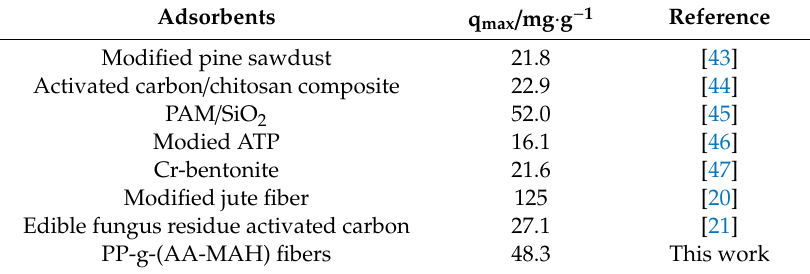
Table 3. Adsorption capacity of various adsorbents for aniline